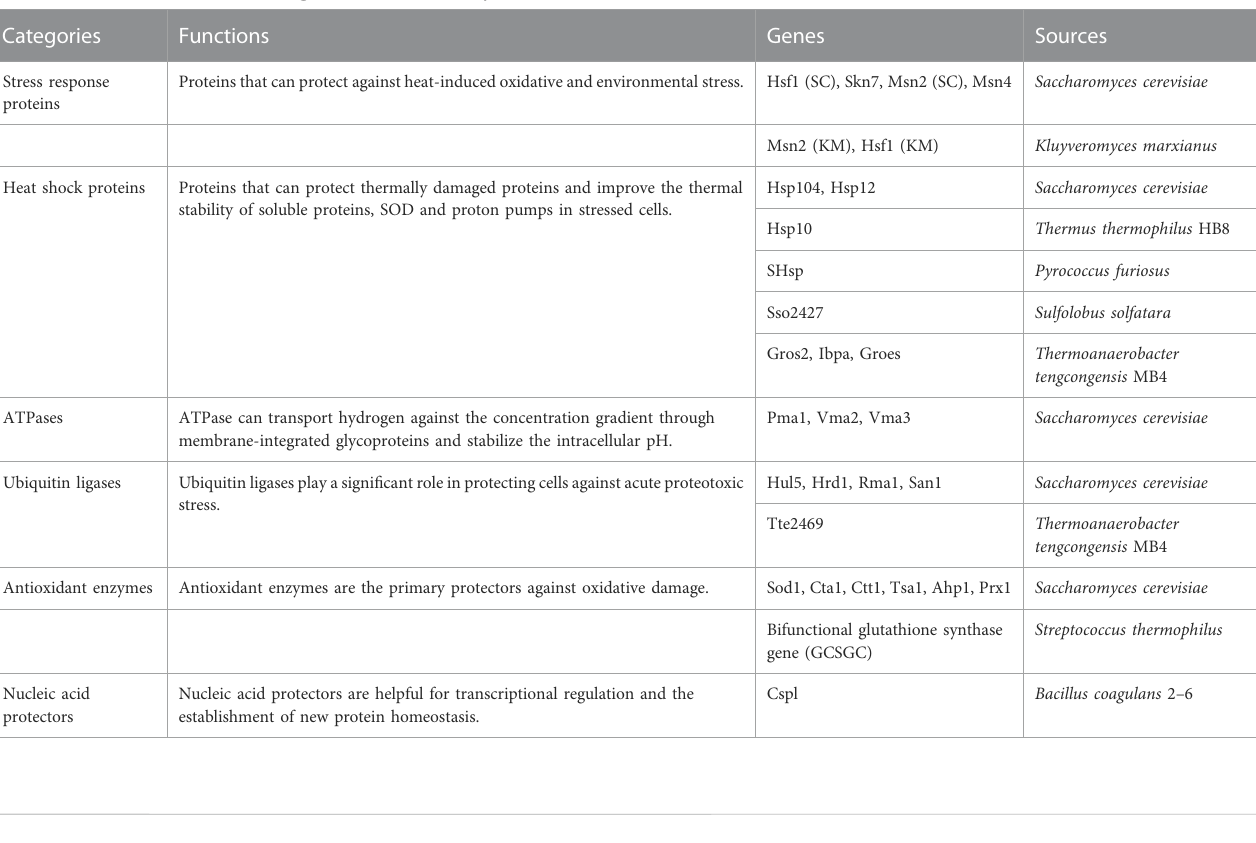
TABLE 1 Information of the functional genes used in this study. Categories Functions